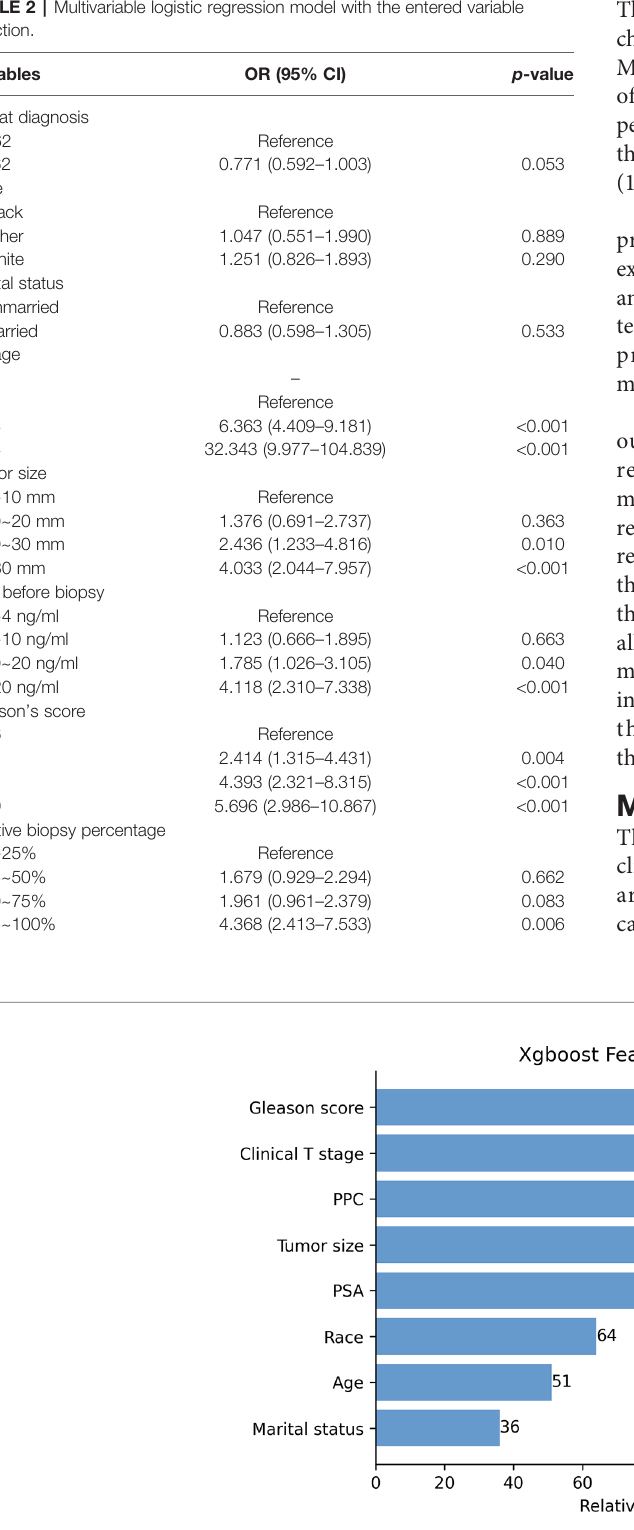
FIGURE 4 | The XGB model was used to calculate the importance of each feature. The bar chart depicts the relative signi fi cance of the variables.